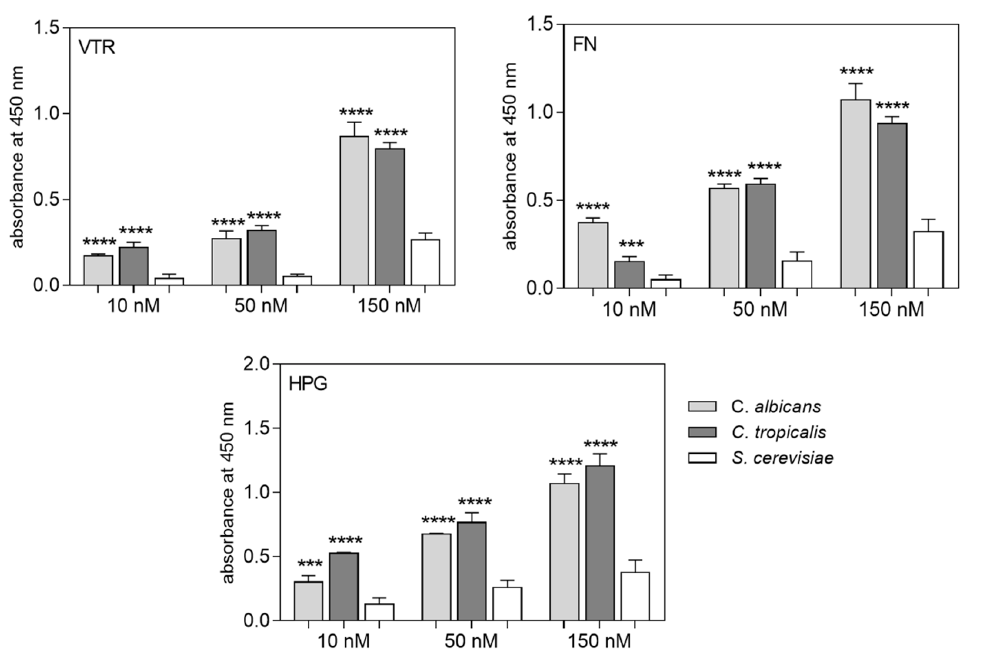
Figure 3. Binding of biotin-labeled fungal enolases to microplate-immobilized VTR, FN and HPG. Microplate wells coated with 3 pmoles of VTR, FN or HPG were filled with 50 µ L of biotin-labeled fungal enolases at increasing concentrations. The amount of bound protein was determined with the SA-HRP / TMB system. The wells without human protein, which were surface-blocked with 3% bovine serum albumin (BSA), served as a control, and the values obtained for these samples were subtracted from the total binding measurements. The bars represent the mean values ± standard deviation (3 determinations). The levels of statistical significance were determined with one-way ANOVA in comparison to the signal obtained for S. cerevisiae enolase; *** p < 0.001 or **** p < 0.0001. The interactions of C. tropicalis enolase with FN, VTR and HPG were additionally analyzed by SPR measurements. Representative sensograms from these experiments are presented in Figure 4, and the determined binding parameters are listed in Table 1 together with those for C. albicans enolases. For all of the candidal enolases and human proteins studied, the binding parameters ⎯ e.g., the K D constants ranging from 10 –7 to 10 –8 M ⎯ were comparable and indicative of quite strong protein- protein interactions. Interestingly however, the SPR method indicated a very poor, if any, interaction of S. cerevisiae enolase with these three human proteins (data not shown).